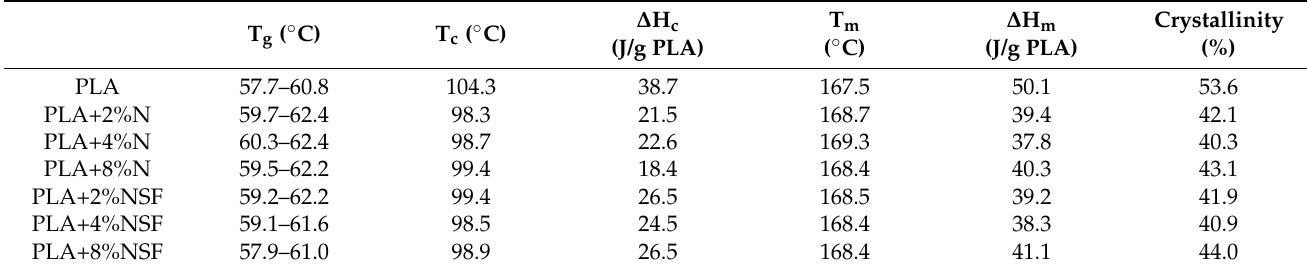
Table 5. Main transition temperatures, cold crystallization and melting enthalpy, and crystallinity of the samples.